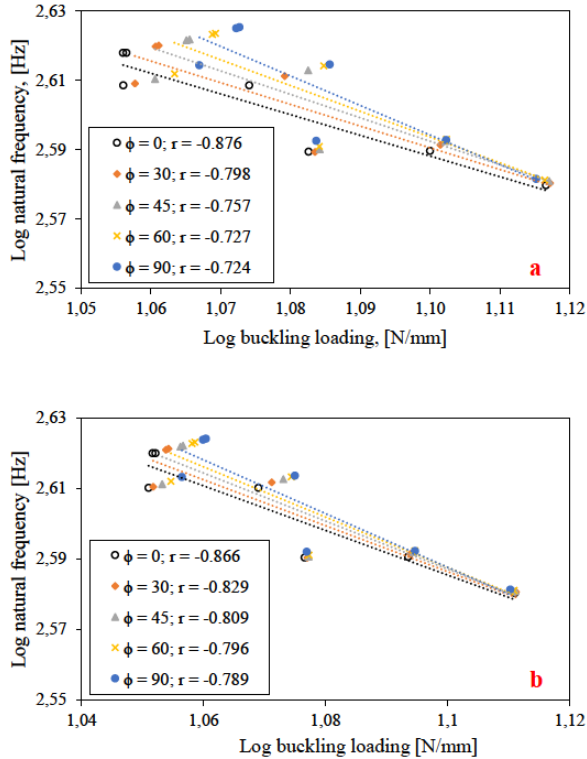
Figure 10: Correlation of natural frequency with buckling load: (a) a/b = 0.6 and (b) =